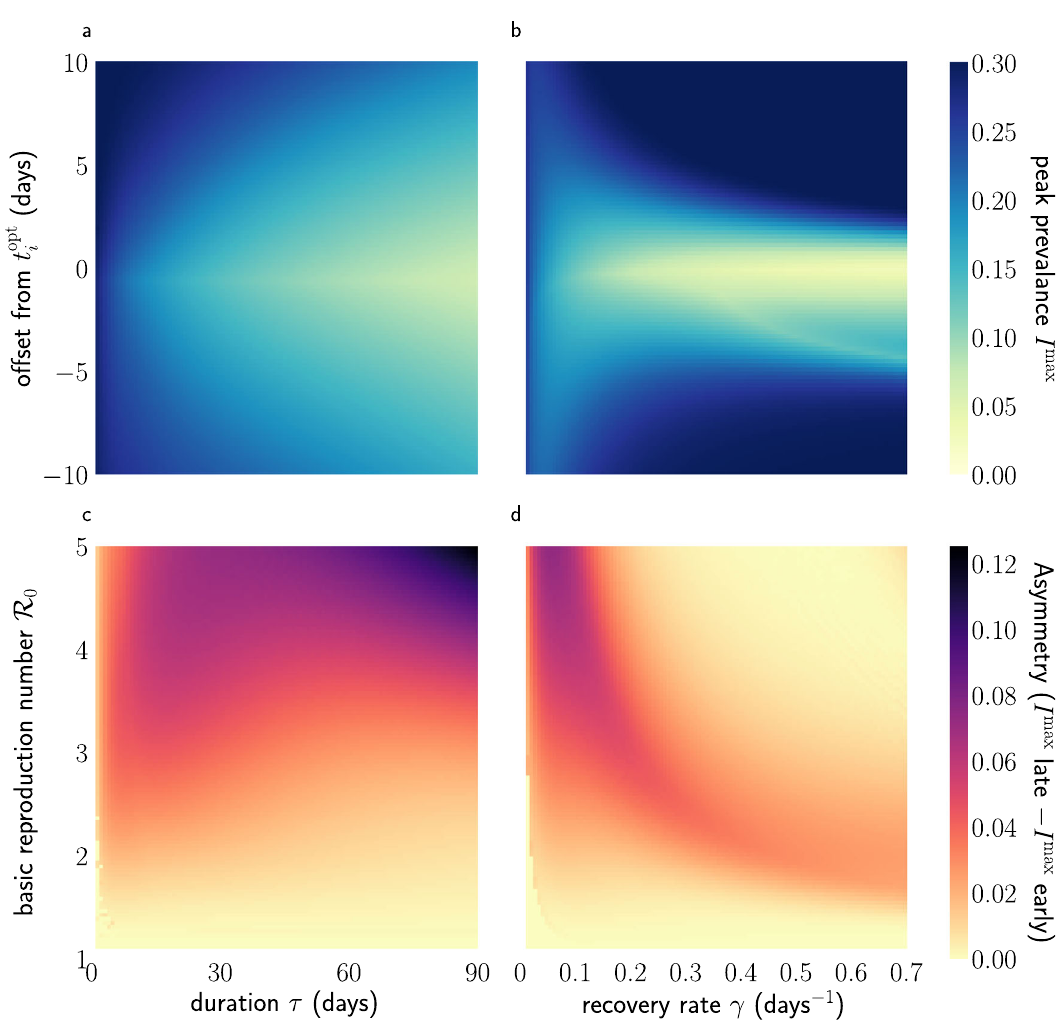
Fig. 3 Effect of parameter variation on peak reduction and robustness to mistiming. a , b , Peak prevalence I max as a function of offset from optimal intervention initiation time t opt i and a intervention duration τ , b recovery rate γ . c , d Asymmetry between intervening early and intervening late, quanti fi ed as I max for a 7-day late intervention minus I max for a 7-day early intervention, as a function of the basic reproduction number R 0 and c duration